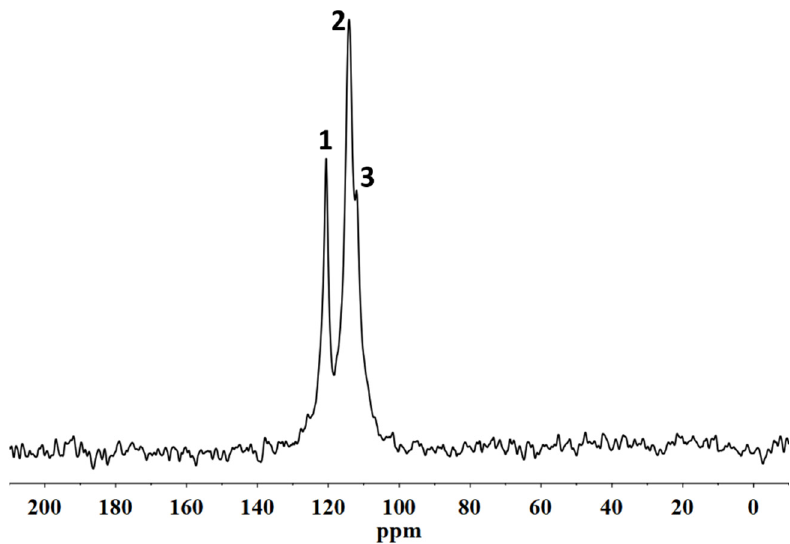
Figure 10. 13 C{ 19 F} CP − MAS NMR spectrum of Fluo AQ film. Table 5. Assignment of the chemical shift of 13 C{ 19 F} CP-MAS.